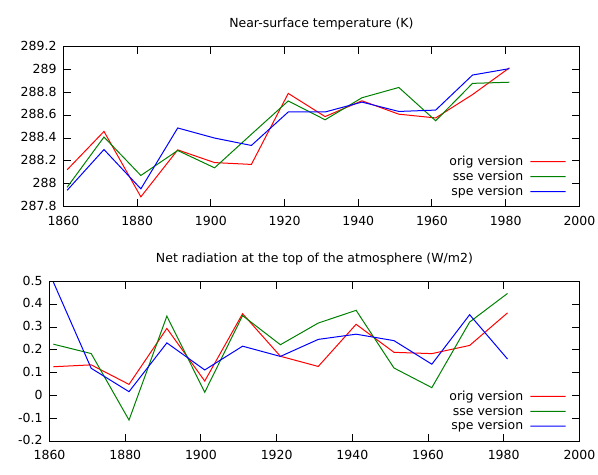
Fig. 3. The exchange of tasks between the top-level radiation function and the threads in the thread pool through the task queue.